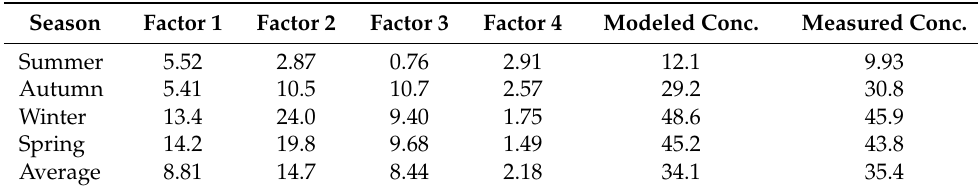
Table 4. Measured and modeled concentrations of PAHs in PM 2.5 (unit: ng/m 3 ). Season Factor 1 Factor 2 Factor 3 Factor 4 Modeled Conc. Measured Conc.